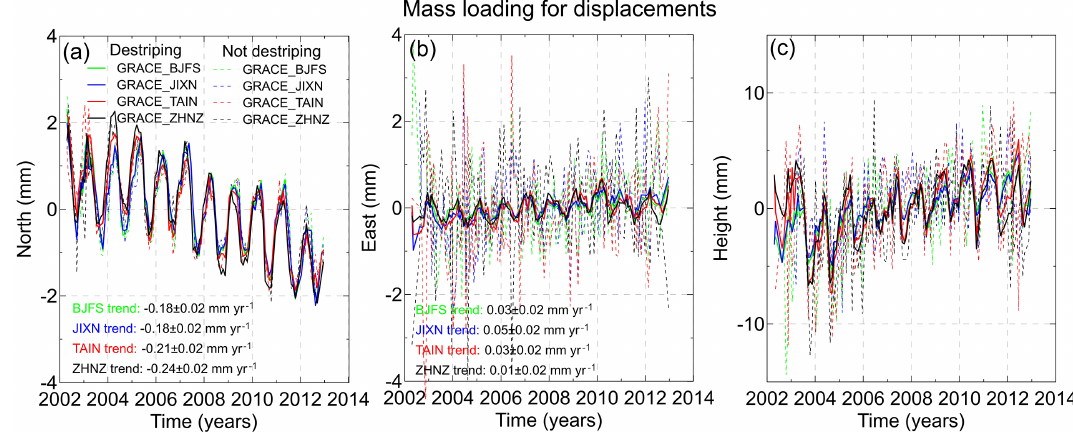
Figure 4. Surface horizontal (north and east components) and vertical deformation modelled by GRACE in four IGS sites. (a) and (b) show the time series and trend rates of north and east components in BJFS, JIXN, TAIN, and ZHNZ respectively, (c) shows the time series of vertical displacements.